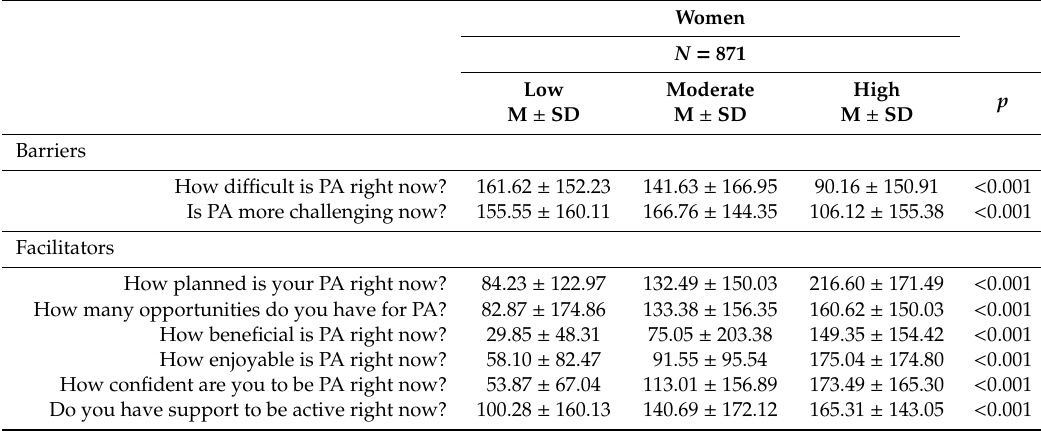
Table 4. ANOVA results for barriers and facilitators to physical activity for women and number of minutes of moderate–vigorous physical activity (min / week).